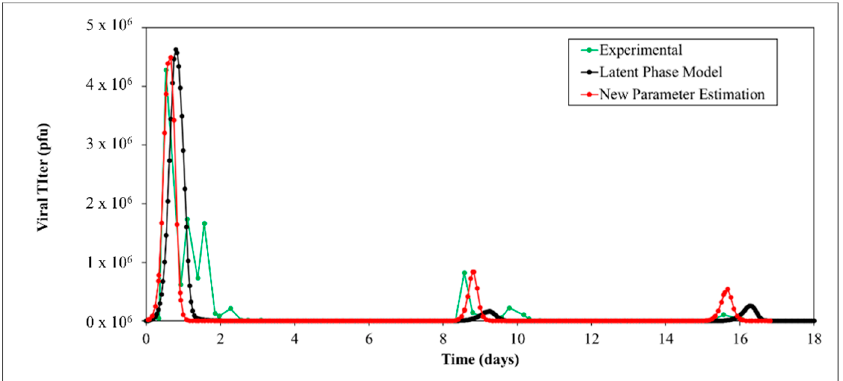
Figure 3. Model comparisons: The figure above shows a comparison between experimental results (green line), the latent-phase model with the literature parameters (black line), and the latent-phase model with the newly estimated parameters (red line).